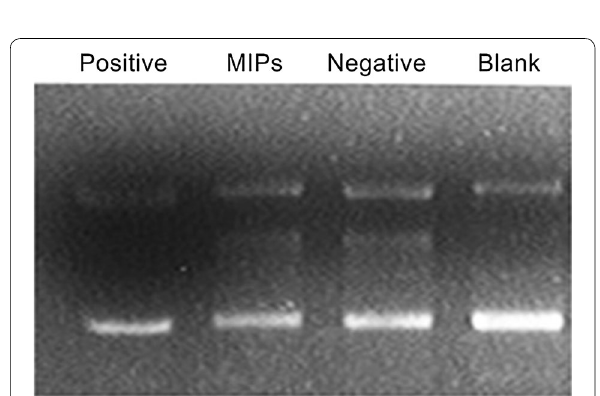
Fig. 7 Inhibitory effect of paclitaxel on HIV-1 integrase